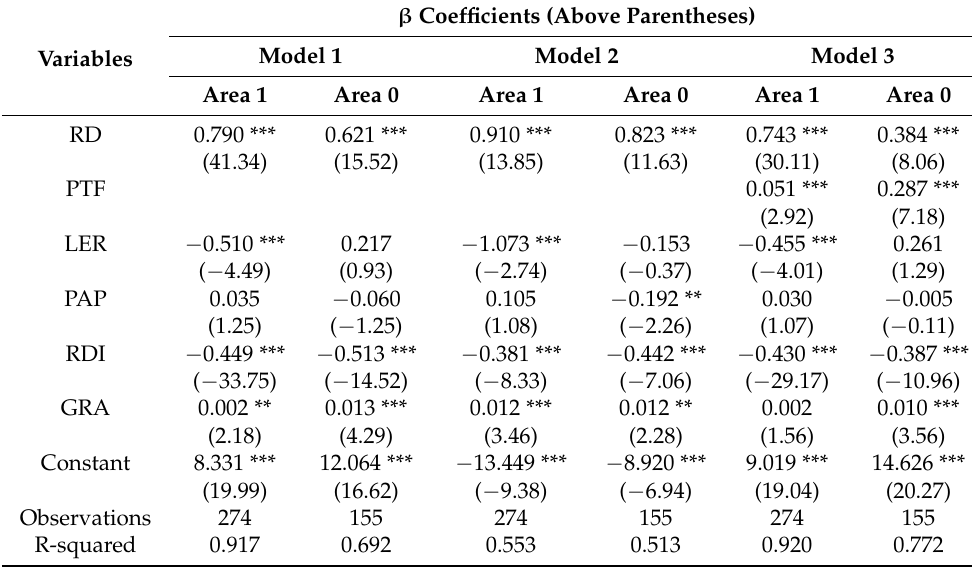
Table 7. Regression results for different